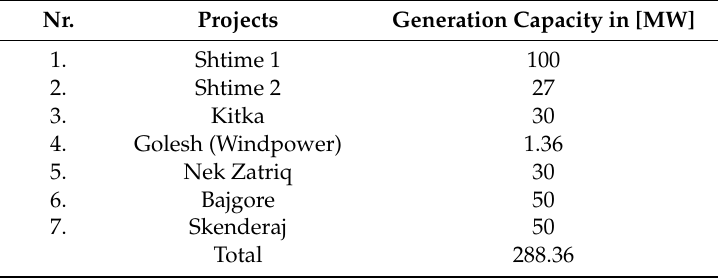
Table 2. Presentation of projects for wind power generation in Kosovo [19].